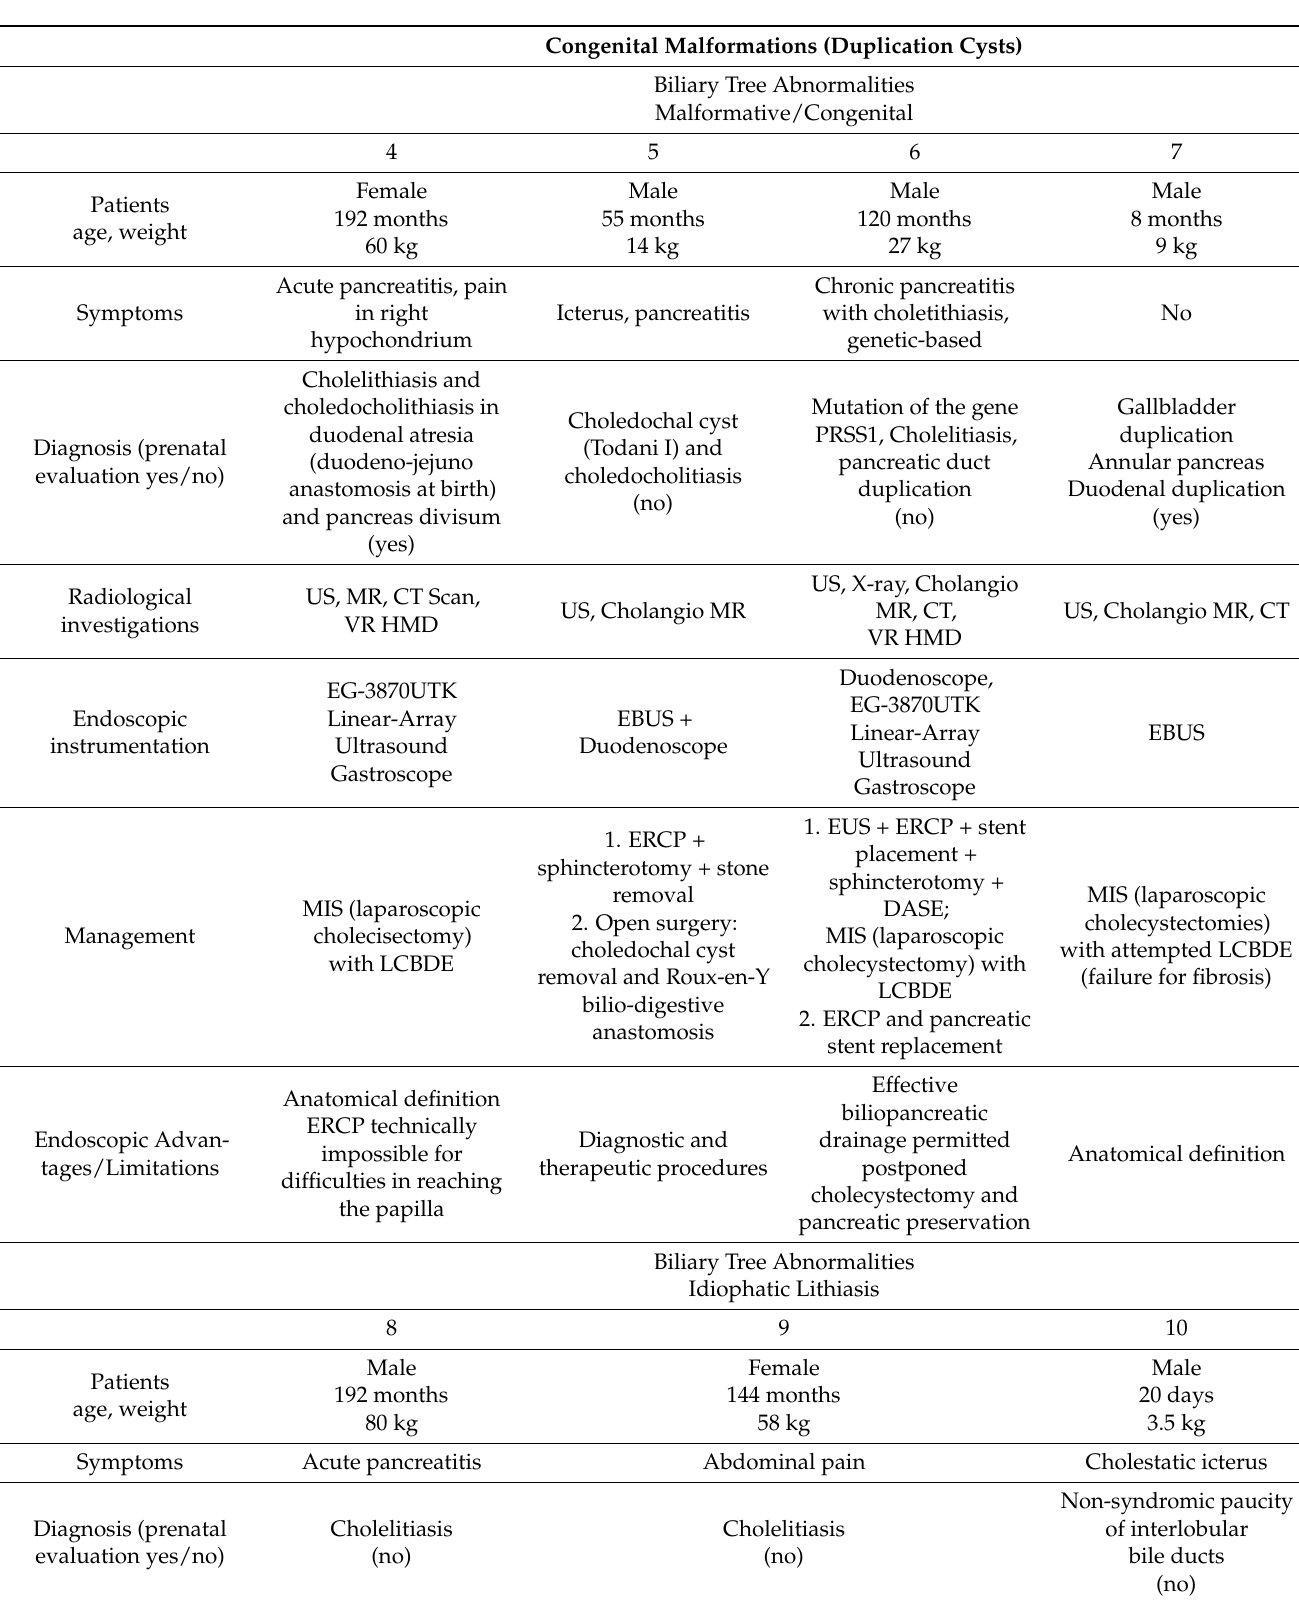
Table 1. Cont. Congenital Malformations (Duplication Cysts) Biliary Tree